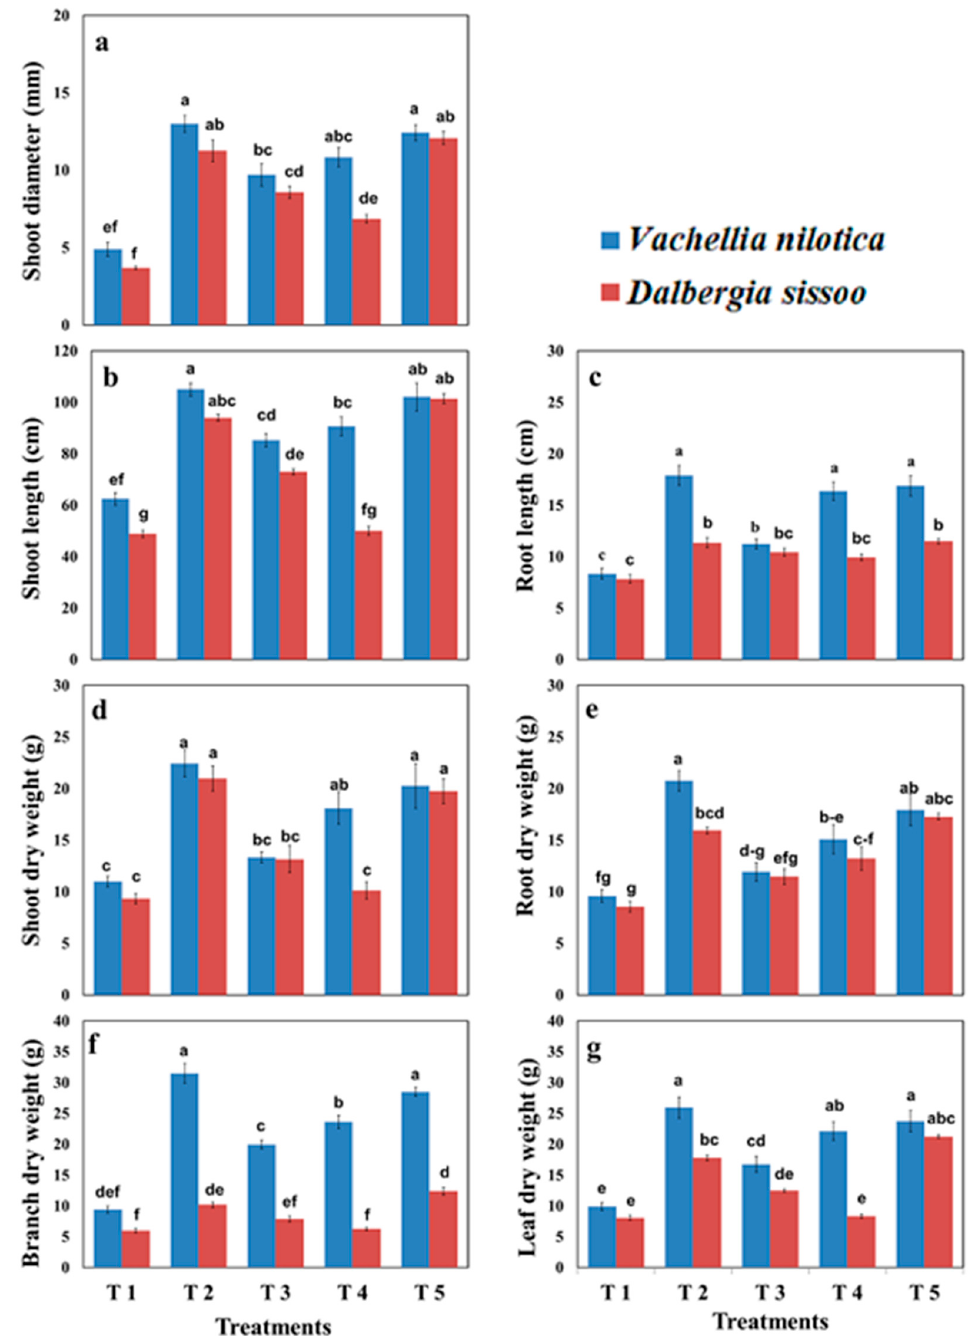
Figure 1. Effects of different organic amendments on ( a ) shoot diameter, ( b ) shoot length, ( c ) root length, ( d ) shoot dry weight, ( e ) root dry weight, ( f ) branch dry weight, and ( g ) leaf dry weight of Vachellia nilotica and Dalbergia sissoo, where T1 = control, T2 = farmyard manure, T3 = poultry manure, T4 = slurry, T5 = biochar. The lower case letters the indicate that values are significantly ( p < 0.05) different from each other.